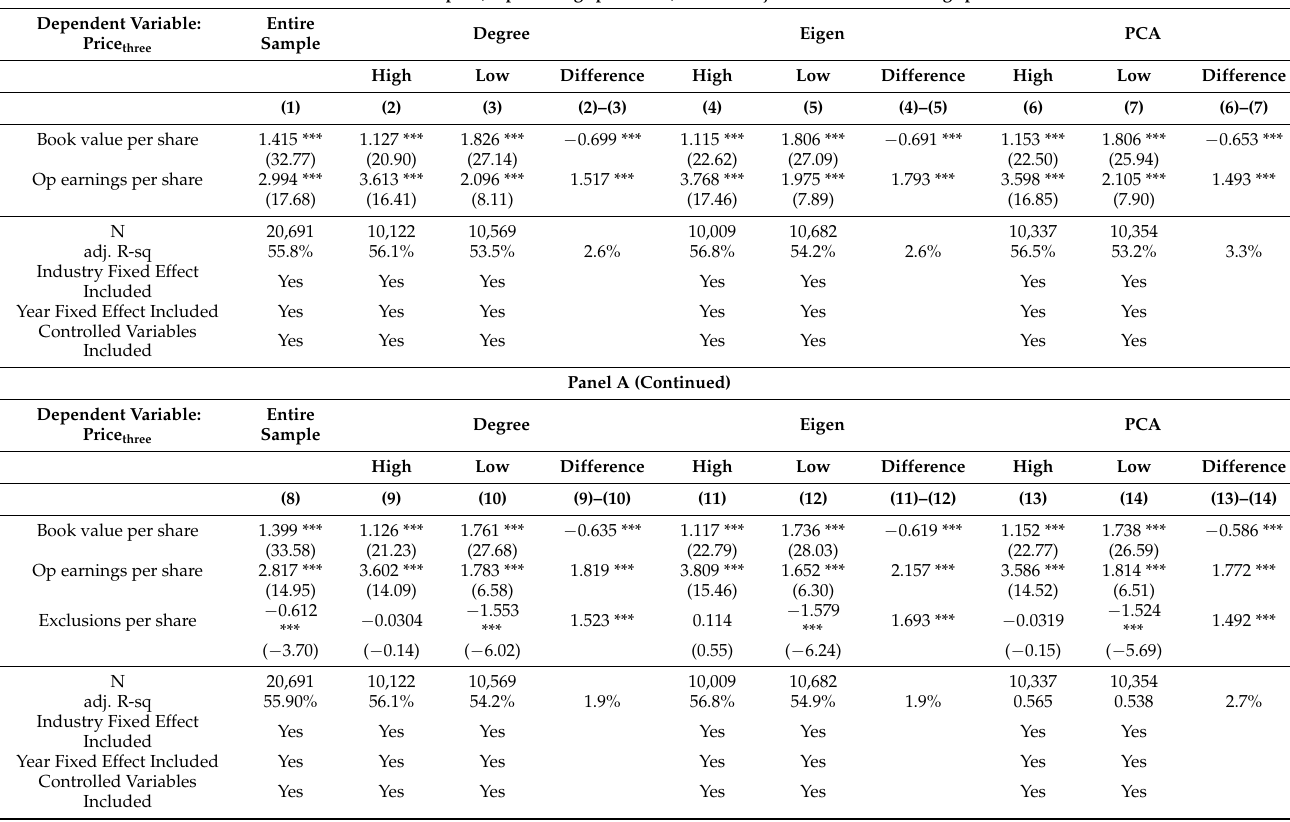
Table 5. Alternative earnings proxies and their adjustments from earnings per share. This table presents the results of the OLS regressions explaining the effect of CEO social capital on the value relevance of book value of equity and alternative earnings proxies and their adjustments from earnings per share. There are two panels in the table: Panel A presents results related to Op earnings per share (operating earnings scaled by number of shares outstanding) and its adjustment: Exclusions per share (difference between net income and operating income scaled by the number of shares outstanding); Panel B presents results related to Cash flow per share (cash flow from operating activities scaled by the number of shares outstanding) and its adjustment: Accruals per share (difference between net income and cash flow from operating activities scaled by number of shares outstanding). In all panels, the dependent variable is Price three , a continuous variable measured by the market price of the common equity at the end of three months after fiscal year-end. CEO social capital is measured by Degree in columns (2), (3), (9) and (10), Eigen in columns (4), (5), (11) and (12) and PCA in column (6), (7), (13) and (14). Variables of interest in the regression include Book value per share (book value of common equity scaled by the number of shares outstanding), alternative earnings proxies and their adjustments from earnings per share. All regressions include control variables as defined in Appendix A. For brevity, the table only presents coefficients related to the variables of interest. All regressions include time- and industry-fixed effects and the errors are robust to firm heteroscedasticity. T-values are reported in parentheses. Statistical significance of the coefficients is designated as *** and * at 1% and 10% levels,